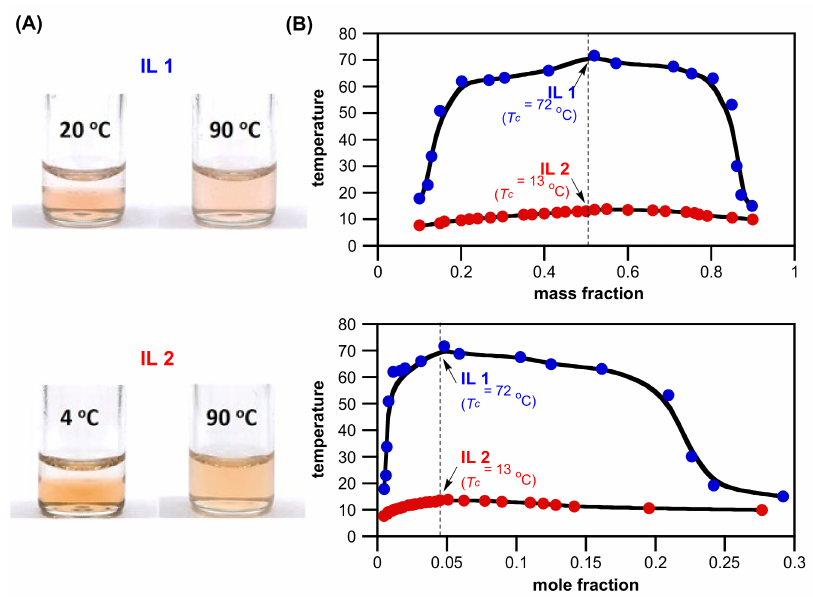
Figure 3. ( A ) Temperature-dependent phase transitions of binary mixtures (1:1, w/w ) of water with IL 1 ( T c = 72 ◦ C) at 20 ◦ C and 90 ◦ C, and IL 2 ( T c = 13 ◦ C) at 4 ◦ C and 90 ◦ C, respectively. The Congo red dye (0.001 wt% in water) was added to make the phase boundary more noticeable. ( B ) Phase diagrams (both T c vs. mass fraction and T c vs. mole fraction) of a mixture of water with IL 1 and IL 2 , respectively. Solid lines are the guide for the eye.